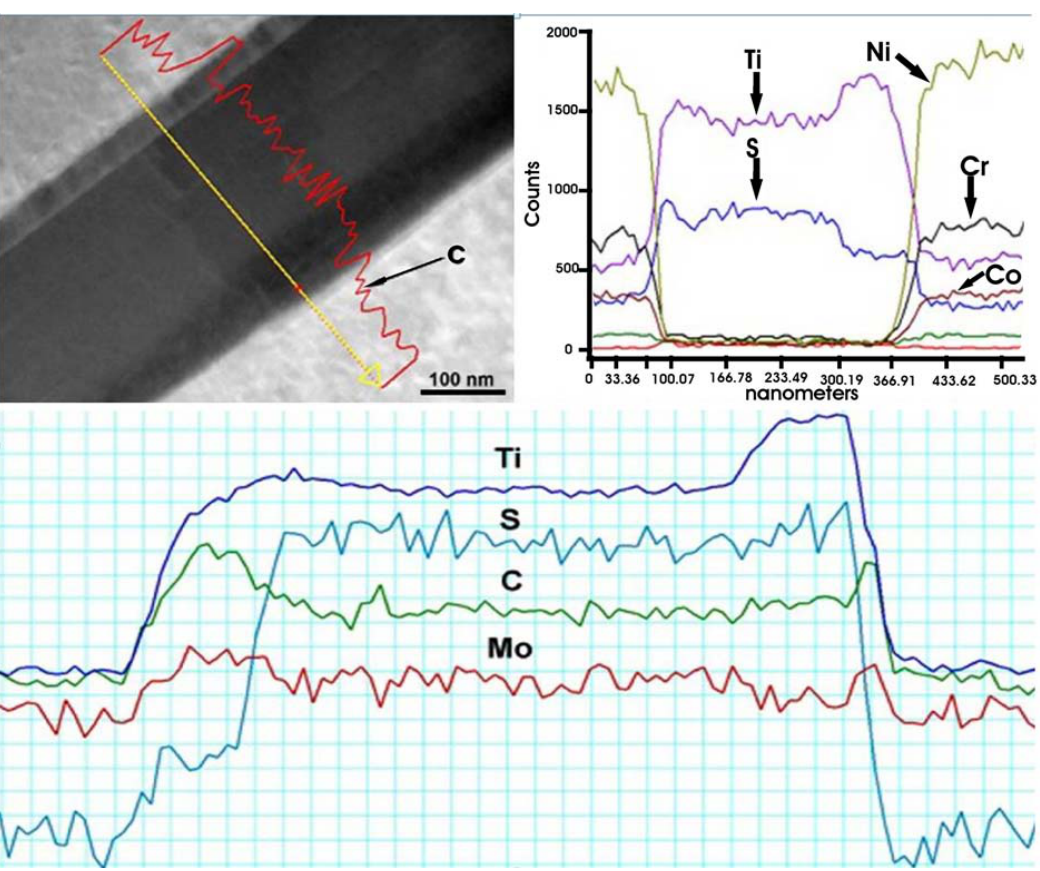
Figure 15. EDS and electron energy-loss spectrometry (EELS) line-scans of elements in SC M 2